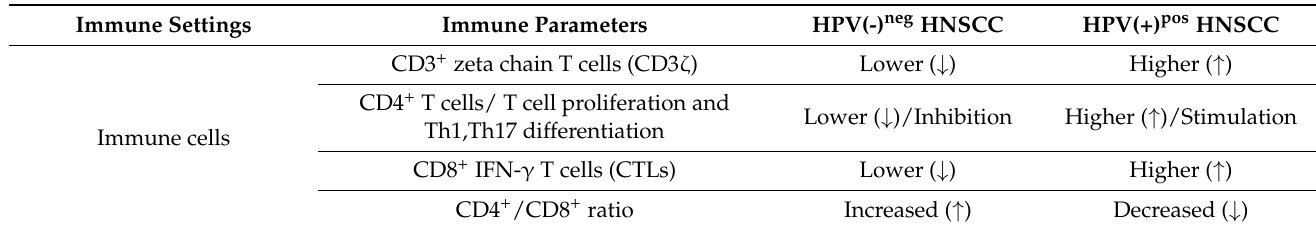
Table 2. Key differences in the immune system modulation between HPV( − ) neg and HPV(+) pos HNSCC. Immune